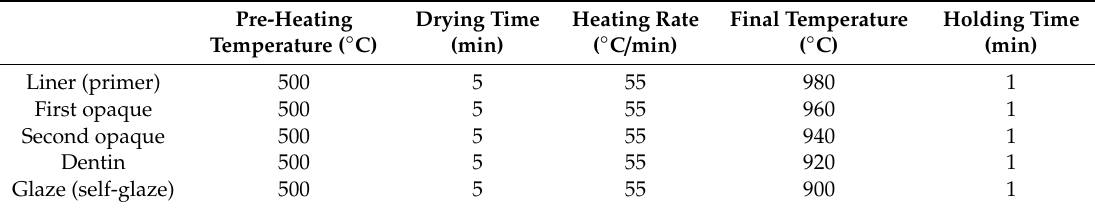
Table 2. Firing schedules for the veneering ceramic.